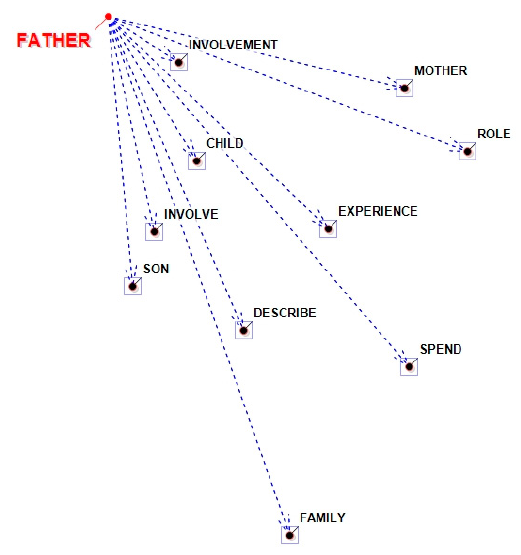
Figure 14. Successors of “father”.